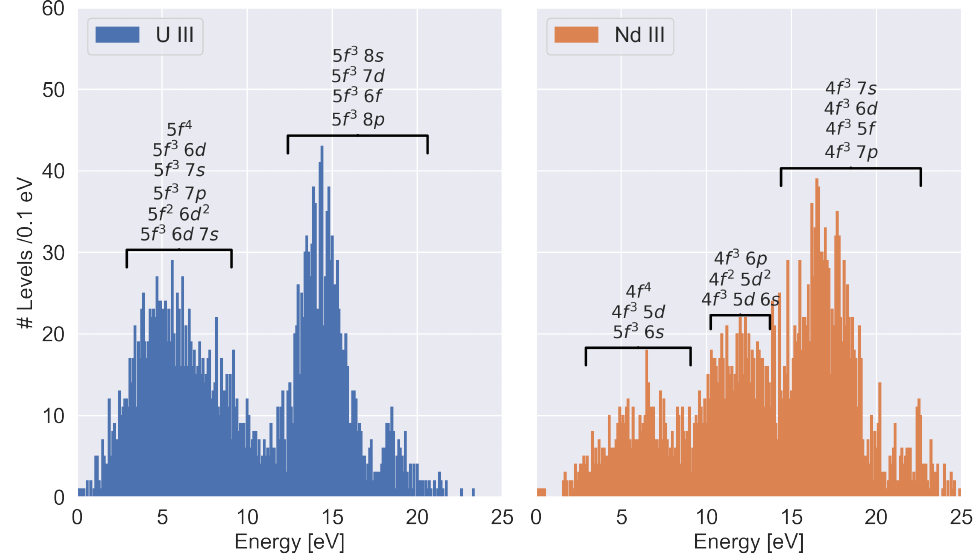
Figure 3. Level density distribution of U III and Nd III as calculated from FAC. The configurations with greater contribution for each peak are also